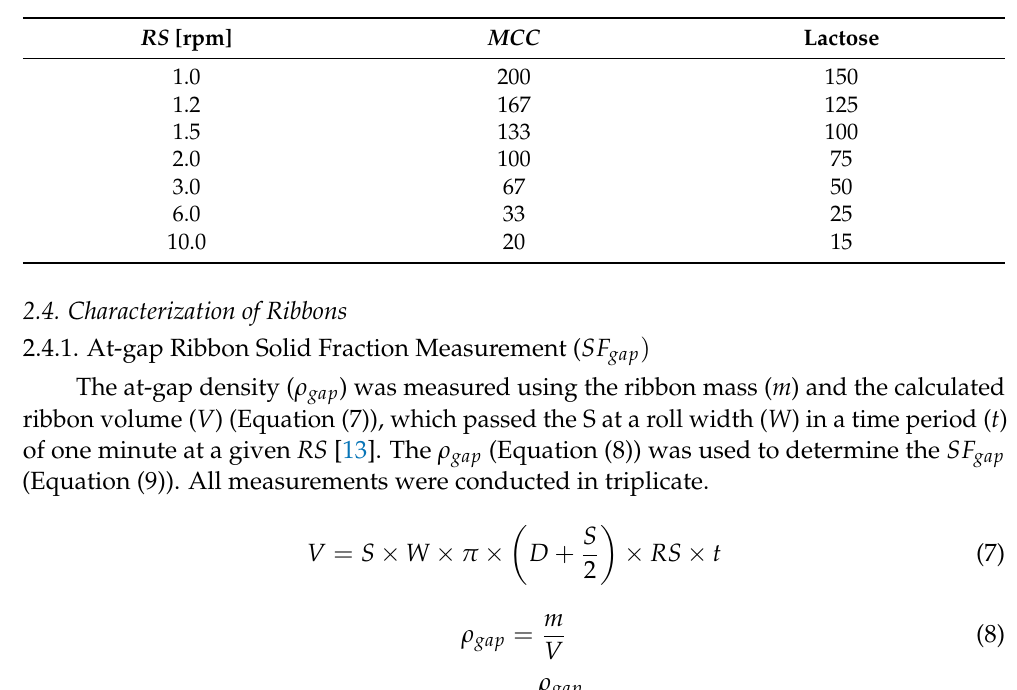
Table 2. DT in ms for the roll compaction of MCC and lactose with different roll